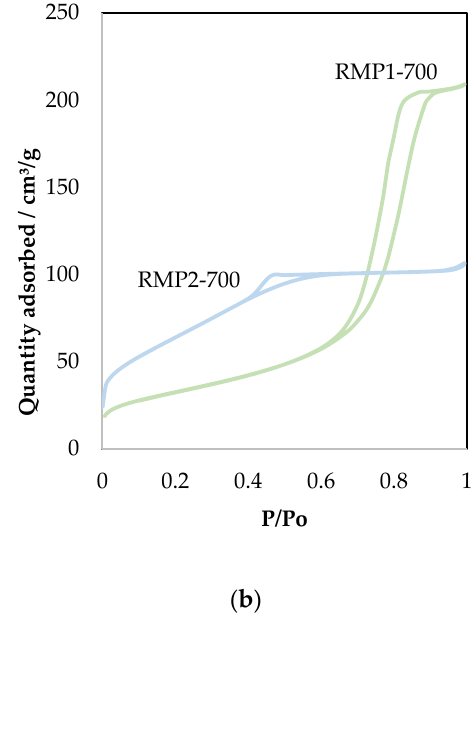
Figure 6. Toluene conversion to CO 2 as a function of the temperature in the presence of the unmodified calcined red mud (RM-500) and the evaporated catalysts (RME1-500 and RME2-500).